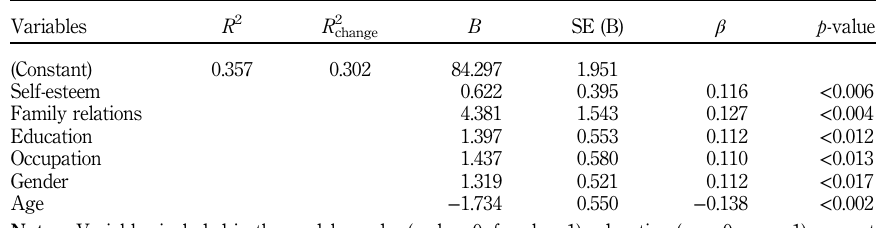
Table IV. Stepwise multiple regression analysis between factors and quality of life among